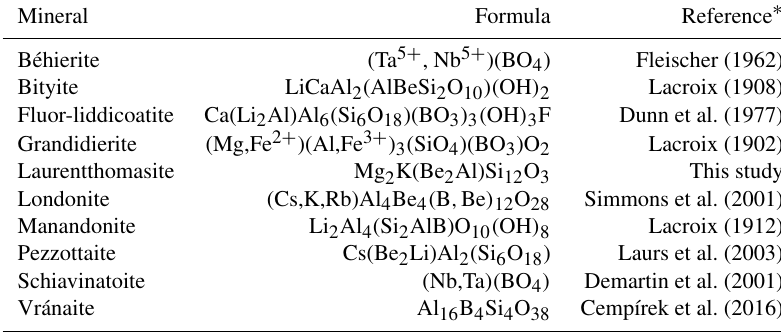
Table 1. Approved mineral species containing Li, Be and/or B from Madagascar.